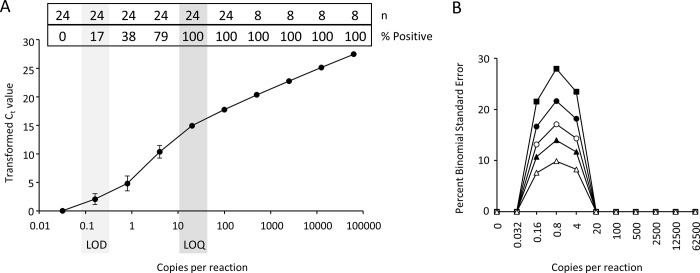
Sensitivity and determination of the limits of detection (LOD) and quantitation (LOQ) for the eASTR4 test using synthetic template DNA.A) Five-fold serial dilutions of a synthetic template DNA were added to the eASTR4 reaction at copy numbers ranging from 62,500 to 0.032 copies per reaction and the mean transformed Ct values (50.001-Ct) determined for each of the eight or 24 technical replicates. The whiskers depict the standard error of the mean. The NTC controls never had any amplification detected. The proportion of technical replicates that passed the Ct cut off for detection (% Positive) and number of technical replicates (n) measured are indicated at the top of the graph for each dilution tested. B) Percent binomial standard error determined at each dilution of synthetic template DNA for differing technical replicates: n = 3 (solid squares), n = 5 (solid circles), n = 8 (open circles), n = 12 (solid triangles), and n = 25 (open triangles).